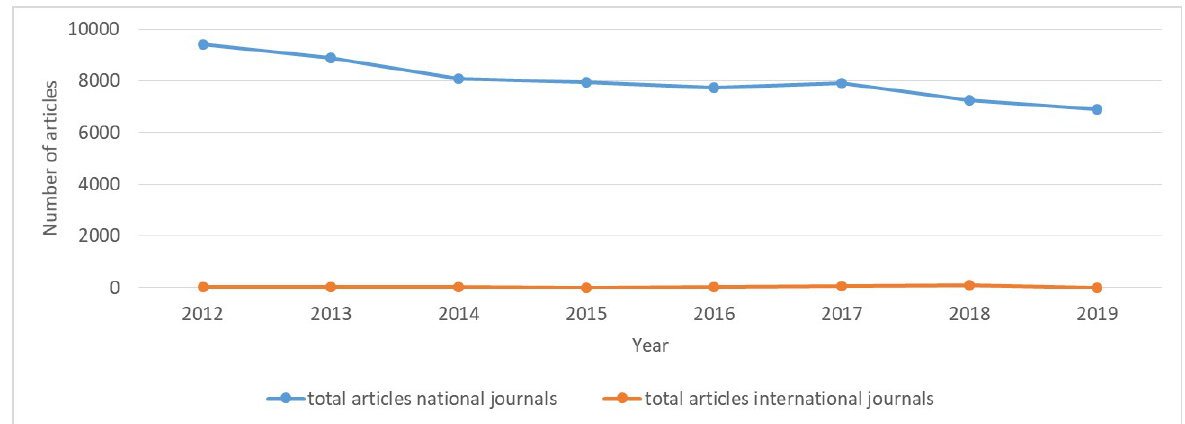
Figure 8. Total number of articles published from journals maintained by national and international non-profit publishers. (Source: the